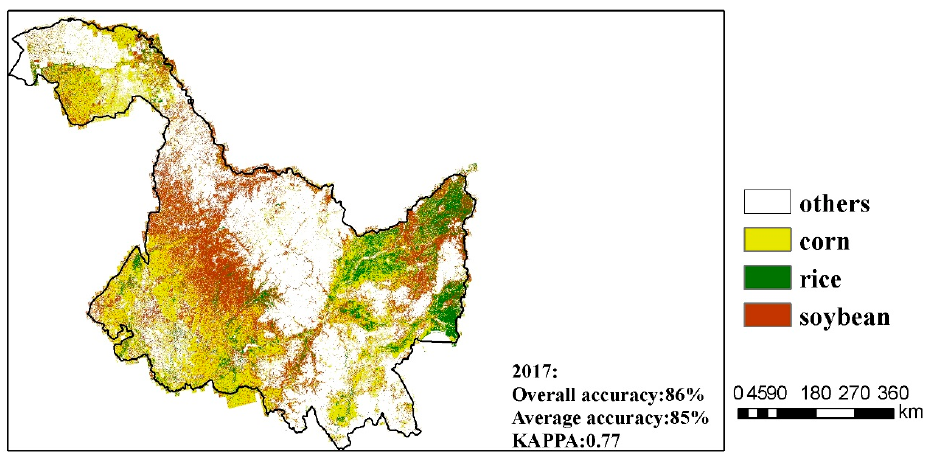
Figure 13. The crop distribution map of Heilongjiang with the overall classification accuracy, average classification accuracy, and Kappa coefficient for year 2015, 2016 and 2017.